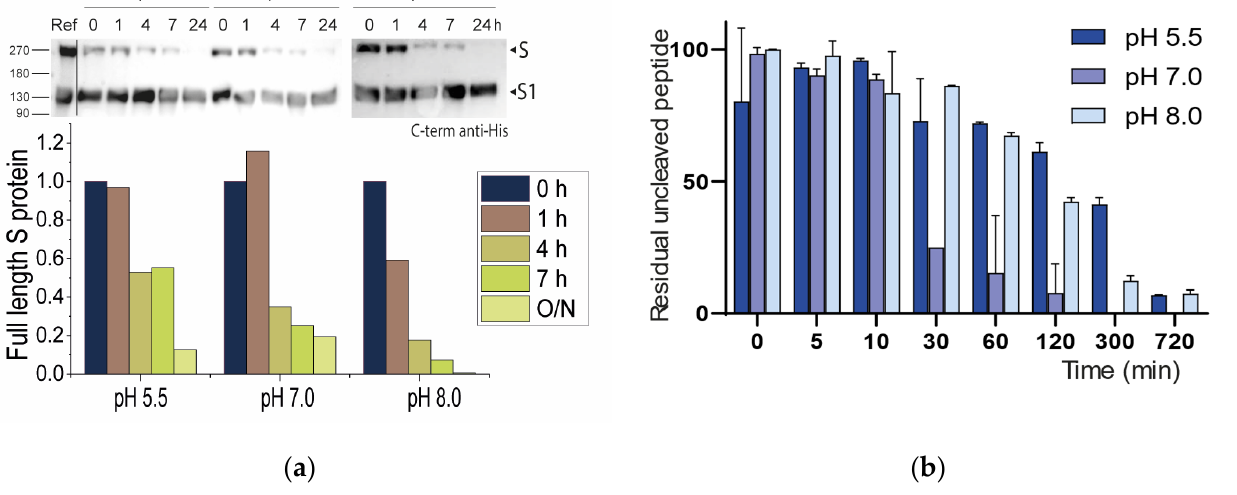
Figure 6 . ( a ) Western blot analyses of SARS ‐ CoV ‐ 2 glycoprotein cleaved at different pH levels. Bands correspond to the FL protein that disappears upon incubation with sFur over time. Control, FL spike, without the addition of sFur. O/N, overnight. Anti ‐ His antibody was used to detect the protein; ( b ) In vitro cleavage of 673 SYQTQTNSPRRAR ↓ SVAS 689 . The peptide was incubated with sFur as described in the Materials and Methods section. Extension of cleavage was evaluated as residual uncleaved peptide detectable by HPLC at 214 nm. Areas under the peak of the uncleaved peptide at time 0 min were arbitrarily taken as reference. Experiments were performed as triplicates.